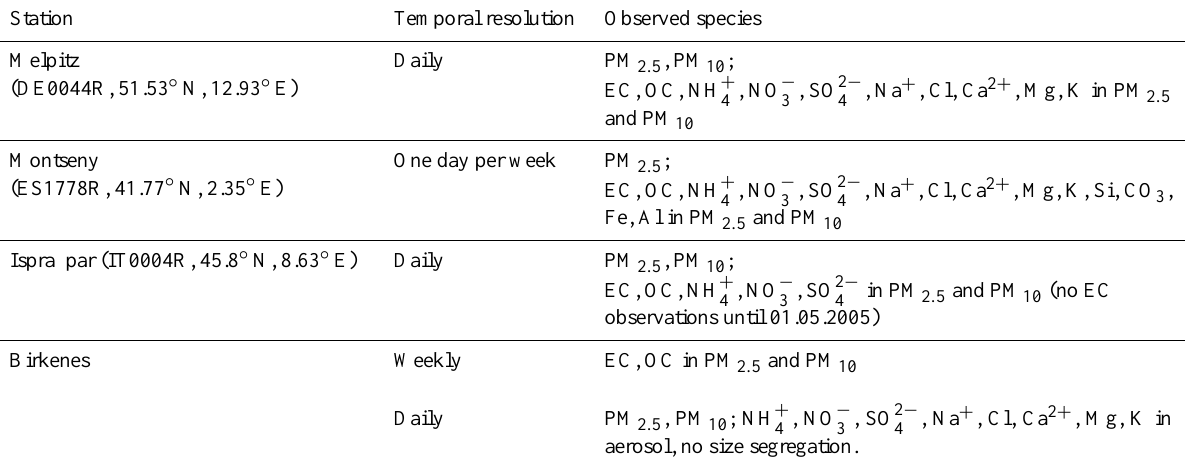
Table 4. The chemical components of PM available from the four EMEP stations that included the EC / OC measurements. Station Temporal resolution Observed